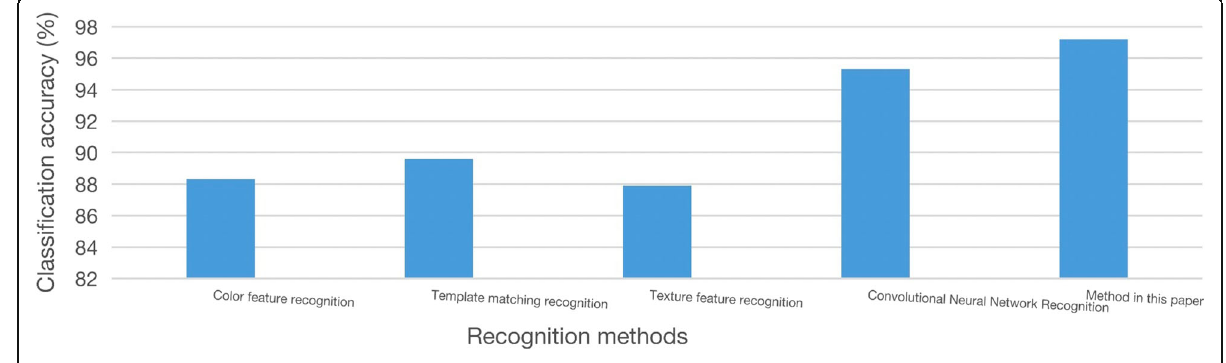
Fig. 5 Performance comparison of different recognition